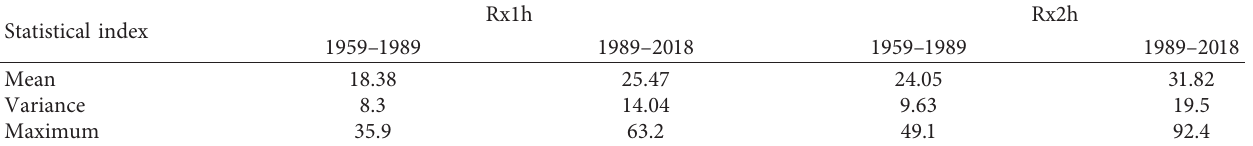
Table 5: Statistical indices of extreme precipitation before and after urbanization in the study